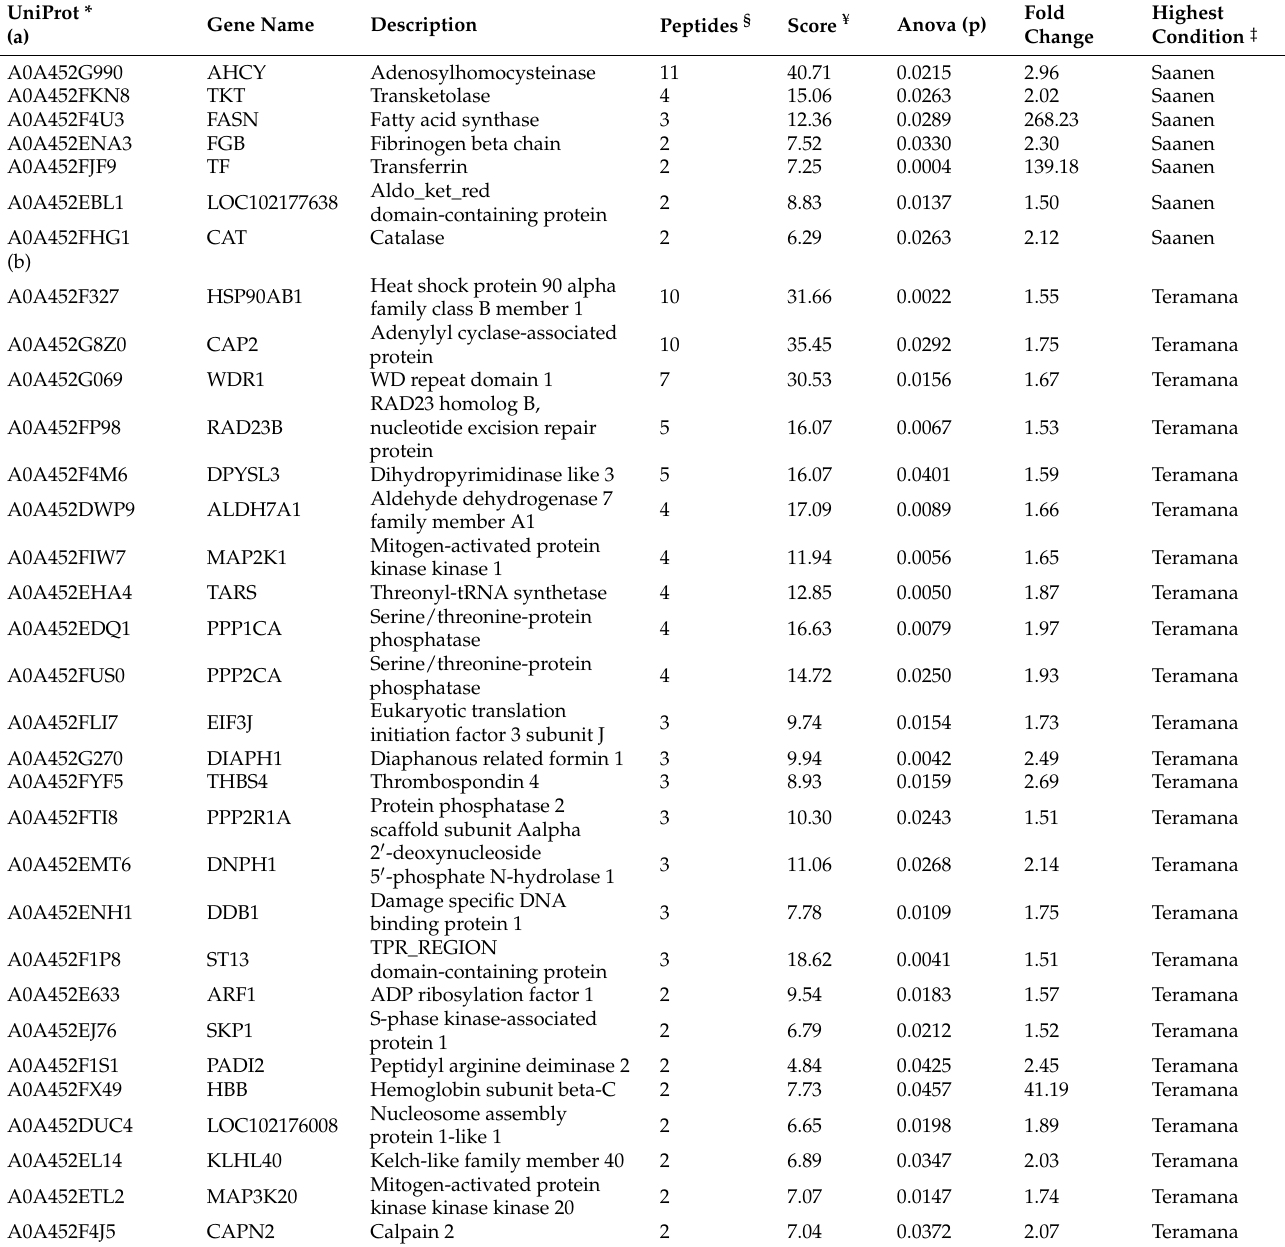
Table 1. Forty-one proteins identified as differentially expressed between the Saanen and Teramana goat breeds following statistical analysis (Progenesis QI for